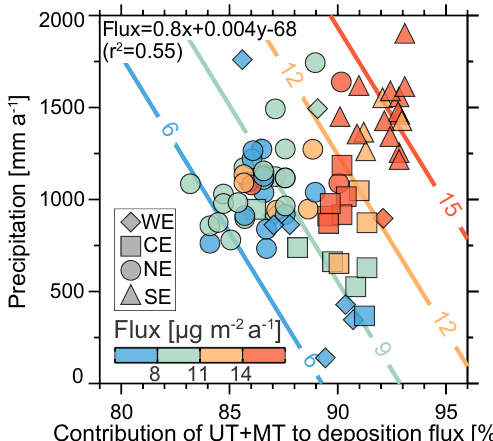
Figure 9. Relationship of observed MDN Hg wet deposition flux (in units of µgm − 2 a − 1 ) to observed precipitation (mma − 1 ) and modeled contribution of UT and MT tracers to the Hg(II) wet de- position flux (%). The symbols identify MDN sites for each region in Fig. 1 (WE: diamonds; CE: squares; NE: circles; SE: triangles), with color-coding according to observed wet deposition flux. Also shown is the multiple linear regression equation relating flux to the contribution of UT + MT tracers ( x ) and the observed precipitation ( y ), as well as the square of the correlation coefficient ( r 2 ). Col- ored contours correspond to deposition fluxes calculated with the regression equation.